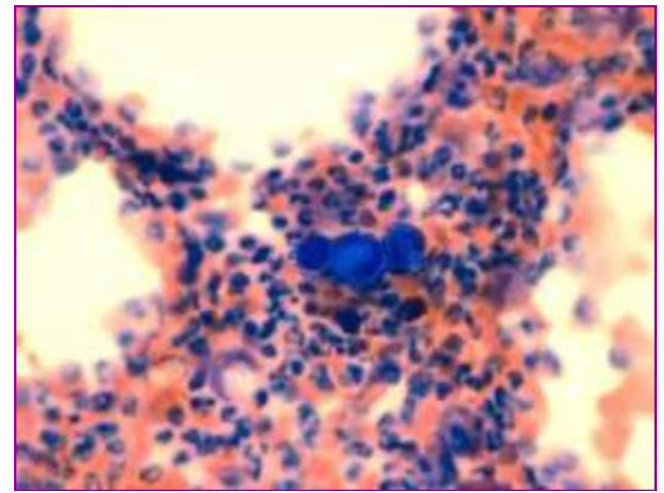
FIGURE 2. B. dermatitidis in bronchial biopsy. (Photomicrograph, original magnification ×100, PAS stain).